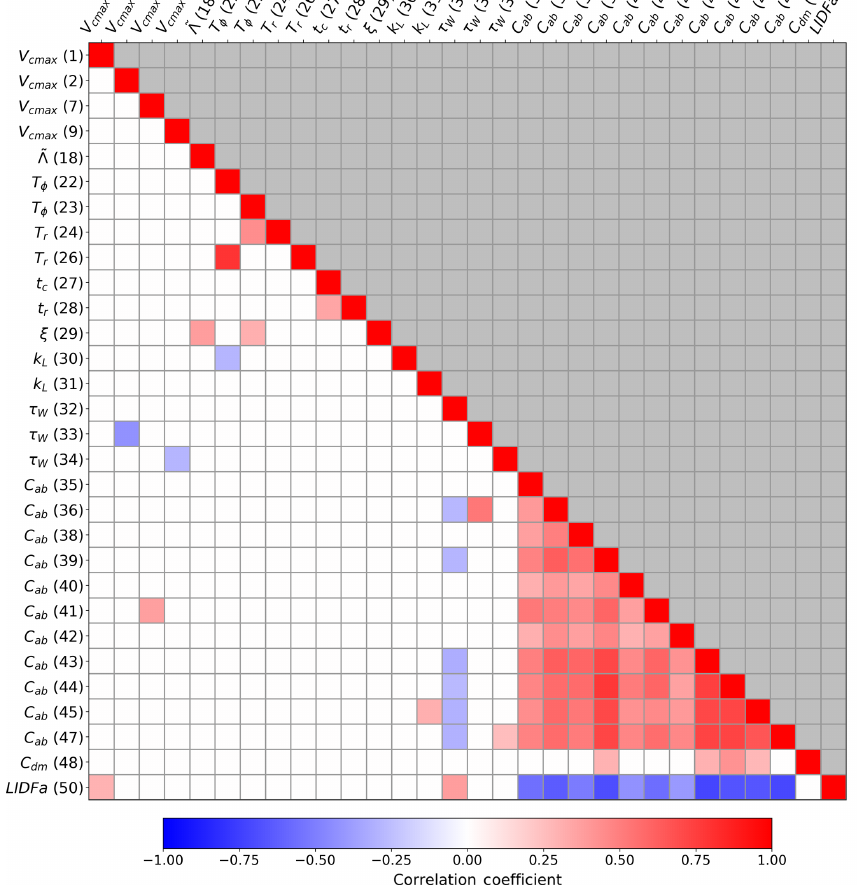
Figure 2. Correlation coefficients ( r value) between parameters in the posterior parameter covariance matrix ( C x nitude and sign of correlations in posterior parameter uncertainties following constraint with SIF data. The axis labels show the parameter symbol and number as defined in Table A1. Only parameters with an absolute correlation coefficient > 0.25 with one or more other parame- ters are shown. Values above and below the diagonal are identical; therefore, those above are coloured